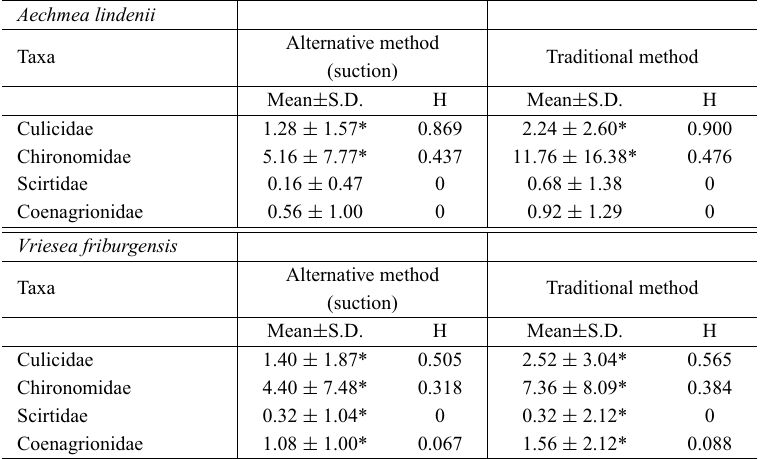
Mean ± S.D. and Shannon-Wiener index (H) of immature forms of insects collected from Aechmea lindenii and Vriesea friburgensis in a restinga area at Florianópolis, SC,